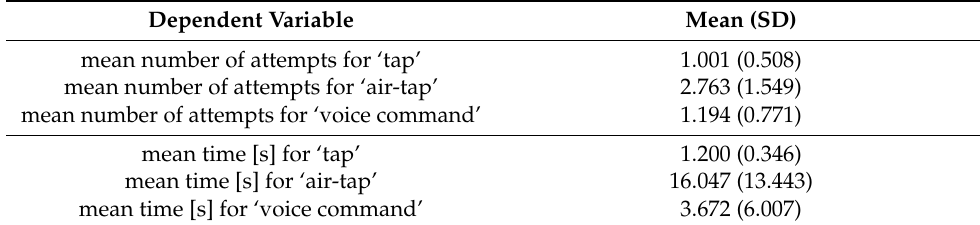
Table 1. Descriptive statistics for the efficiency assessment.